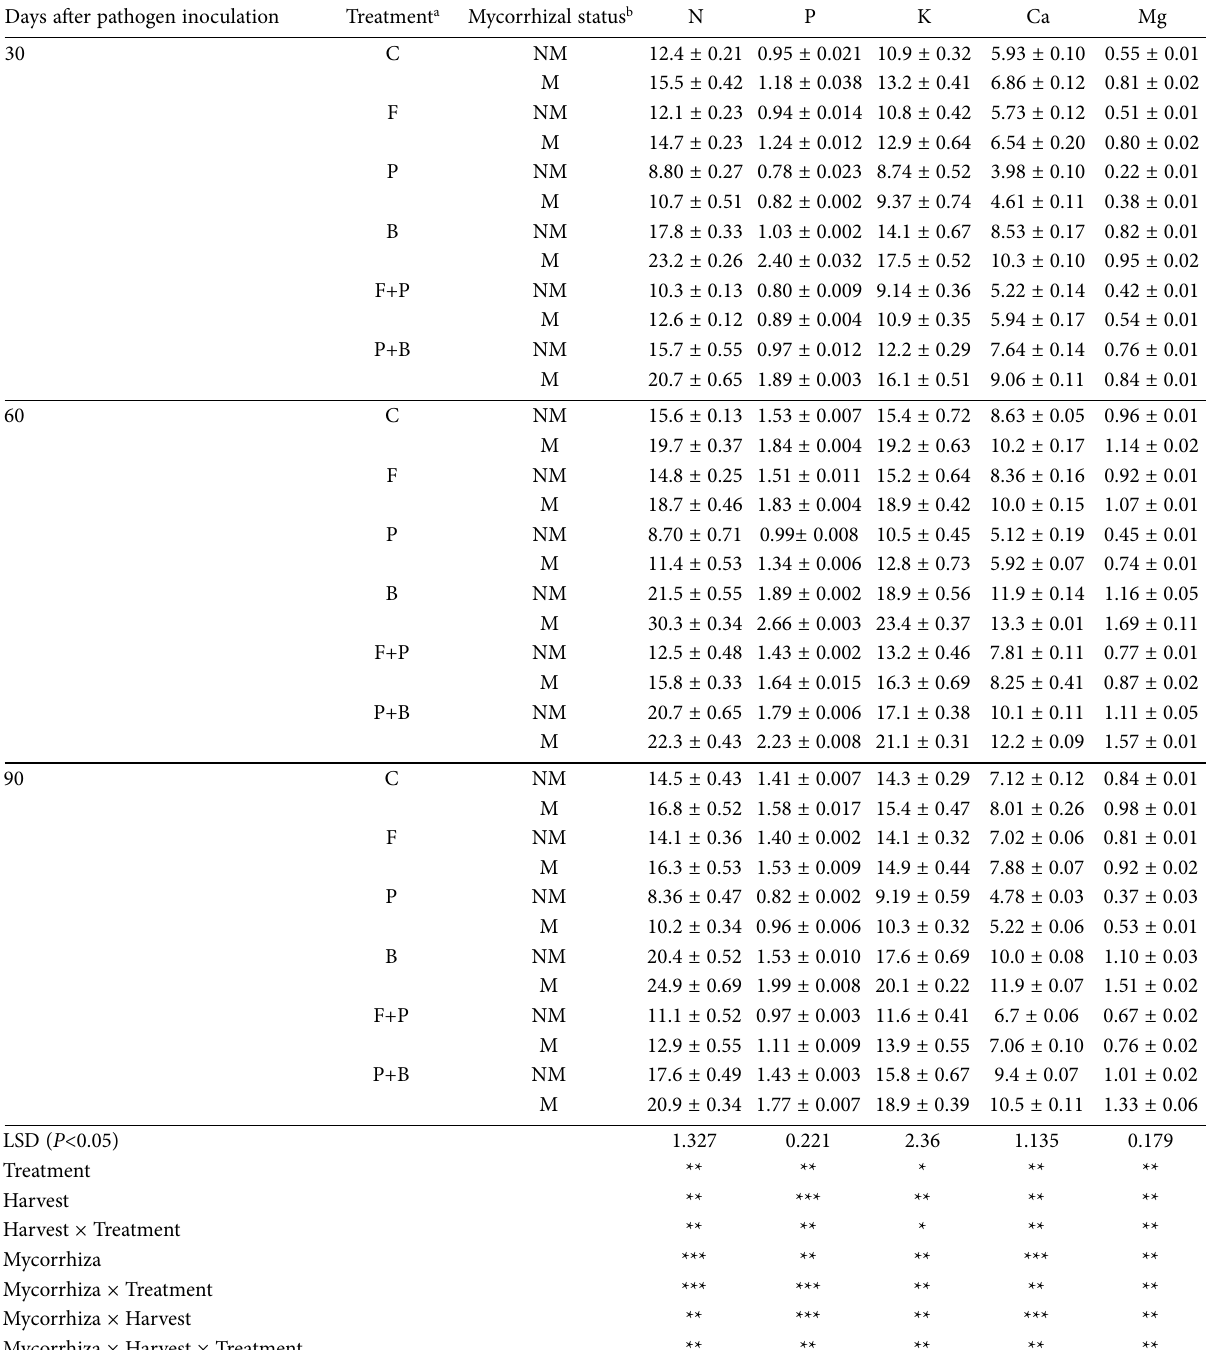
Table 6. Mean amounts (mg g -1 dry weight, ± standard error) of mineral nutrients in garlic plant leaves contents at intervals after different Sclerotium cepivorum inoculation and microbial treatments were